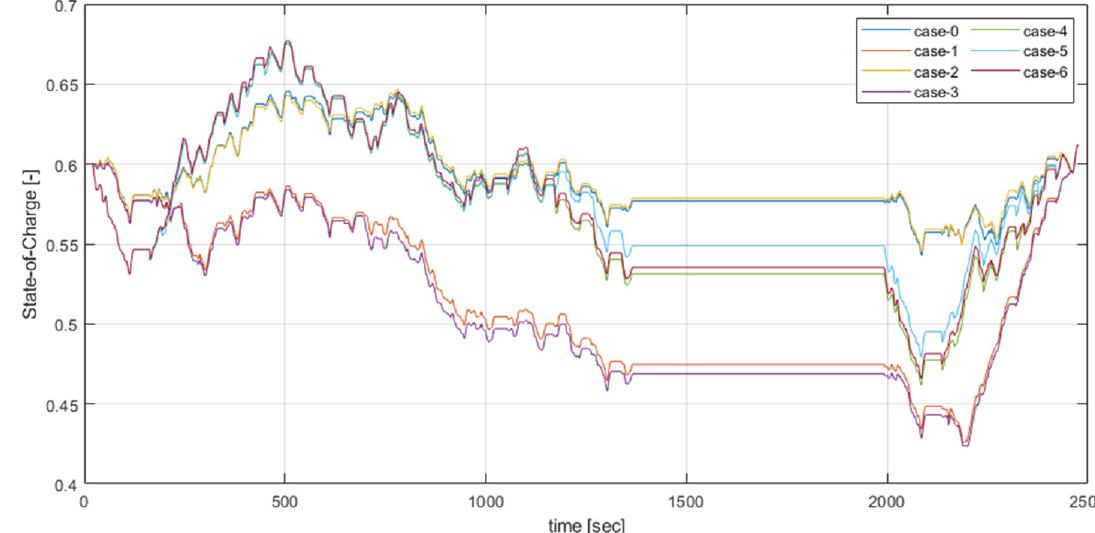
Figure 9. Comparison of DP results (1): state of charge.